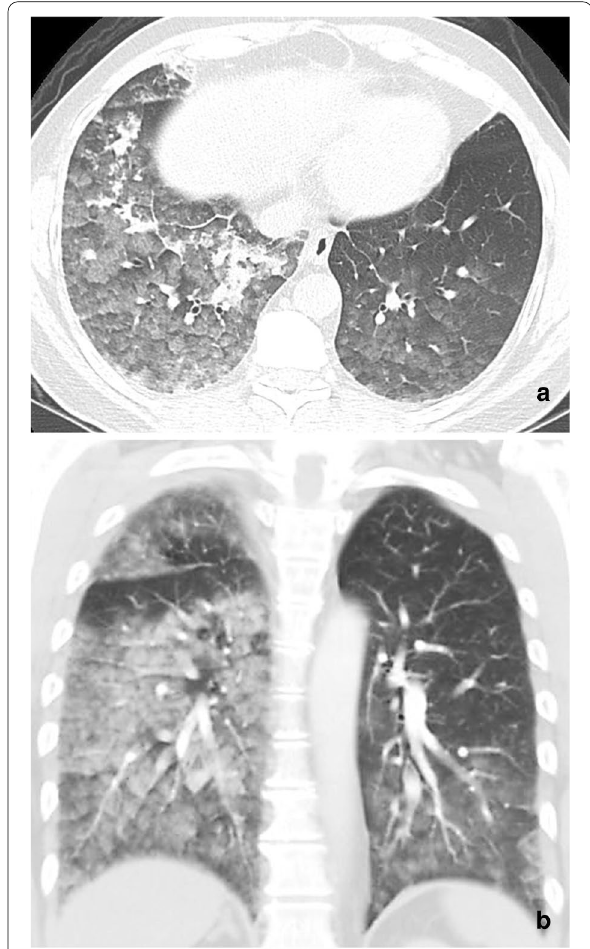
Fig. 11 Non‑infectious mimickers of indeterminate COVID‑19. A 63‑year‑old man with diffuse alveolar hemorrhage secondary to thrombolytic therapy for myocardial infarction. a , b axial and coronal reformatted HRCT images show asymmetric bilateral patchy areas of GGO with small areas of consolidation